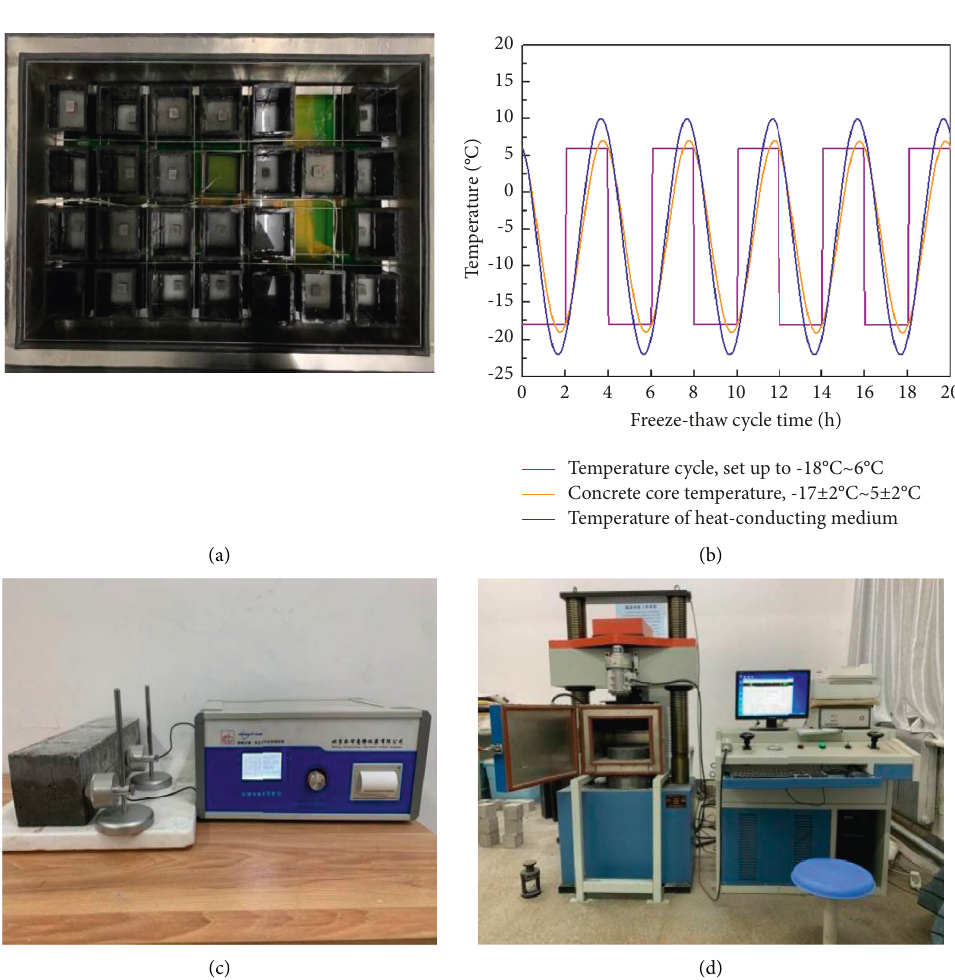
Figure 1: Actual experimental pictures. (a) Freeze-thaw cycle test. (b) Temperature control curve of freeze-thaw. (c) Dynamic modulus test. (d) Uniaxial compression testing